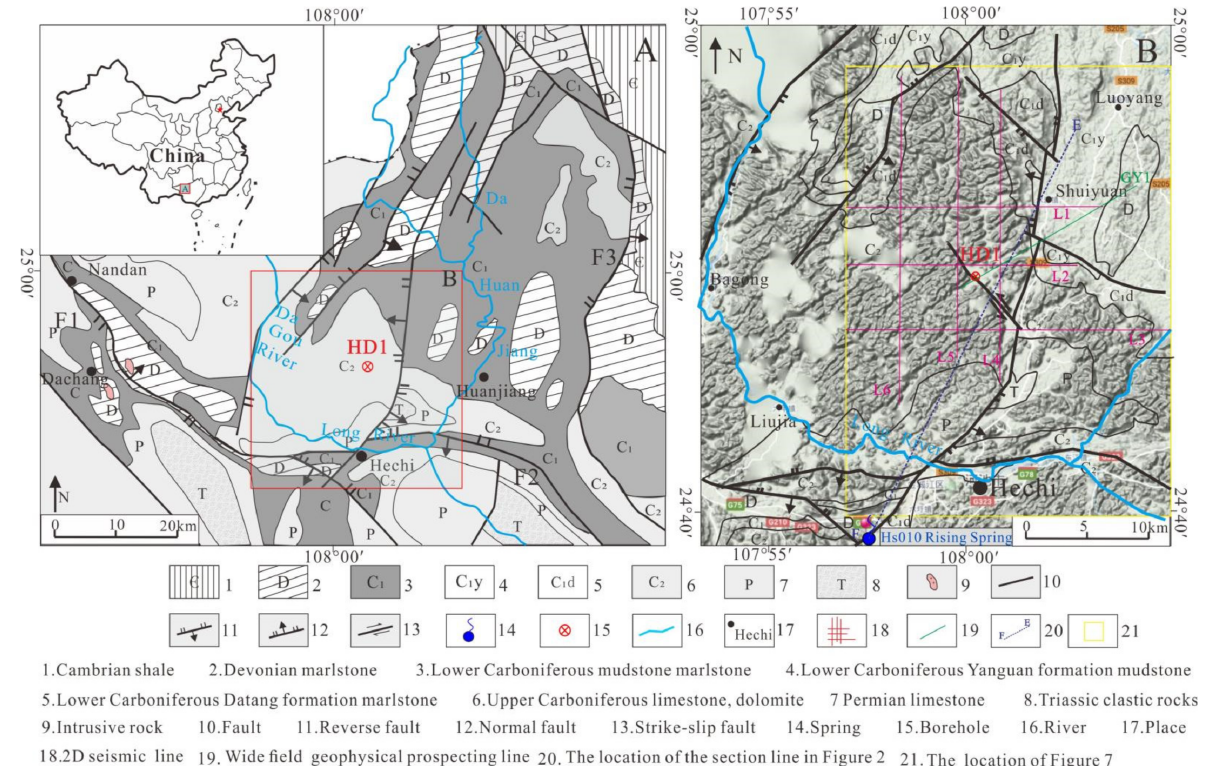
Figure 1. Tectonic location of the Huanjiang area. ( A ) Regional geological map of Huanjiang Sag, Guangxi. ( B ) Karst geomorphic map of Huanjiang Sag, Guangxi. Note: Figure 1A is from a geological survey of Guangxi, 1971 [28]; ( B ) is from Google